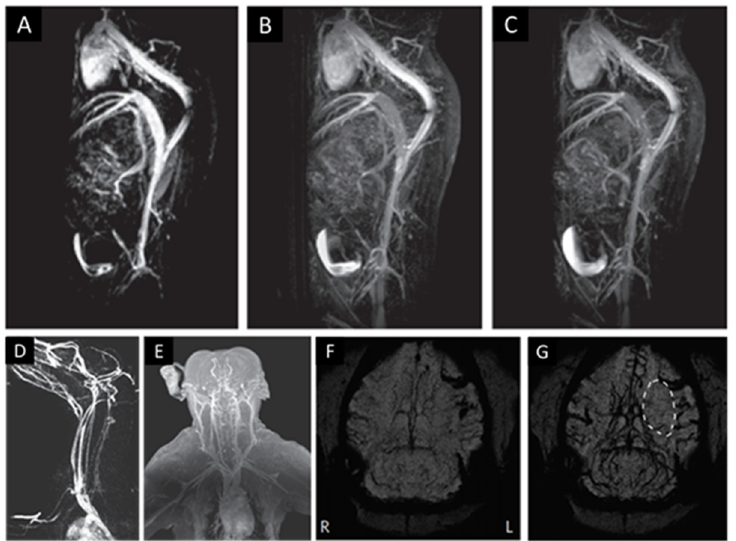
Figure 3. T 1 -weighed MRA of a mouse at ( A ) 4, ( B ) 12, and ( C ) 20 min post injection with ZES- SPIONs. MRA of ( D ) canine (beagle) and ( E ) non-human primate (macaque) animal models post PEG-IONC injection. Dynamic susceptibility contrast perfusion-weighted images of left cerebral ischemia in a macaque ( F ) before and ( G ) after bolus injection of PEG-IONC. ( A – C ) Reproduced with permission from Wei et al., Proceedings of the National Academy of Sciences of the United States of America; published by National Academy of Science, 2017. ( D – G ) Reproduced with permission from Lu Y. et al., Nature Biomedical Engineering; published by Springer Nature, 2017.